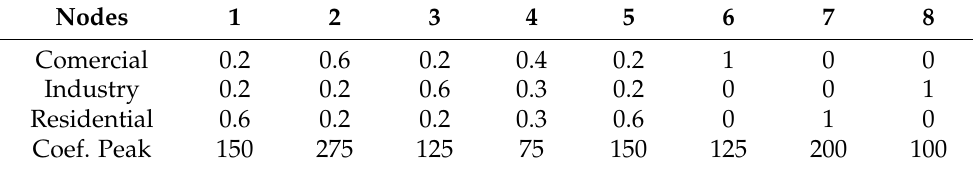
Table A2. Table representing the parameters regarding demand type in TS.